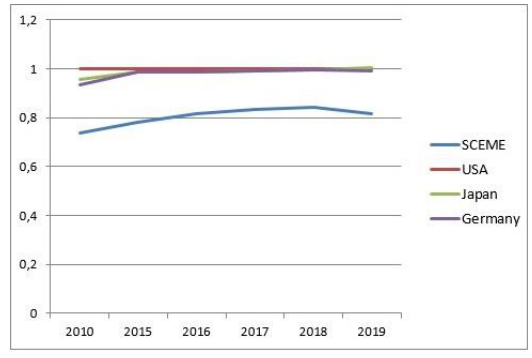
Figure 5. Total Factor Productivity * SCEME: without Vietnam, Cambodia and Myanmar Source: Tables